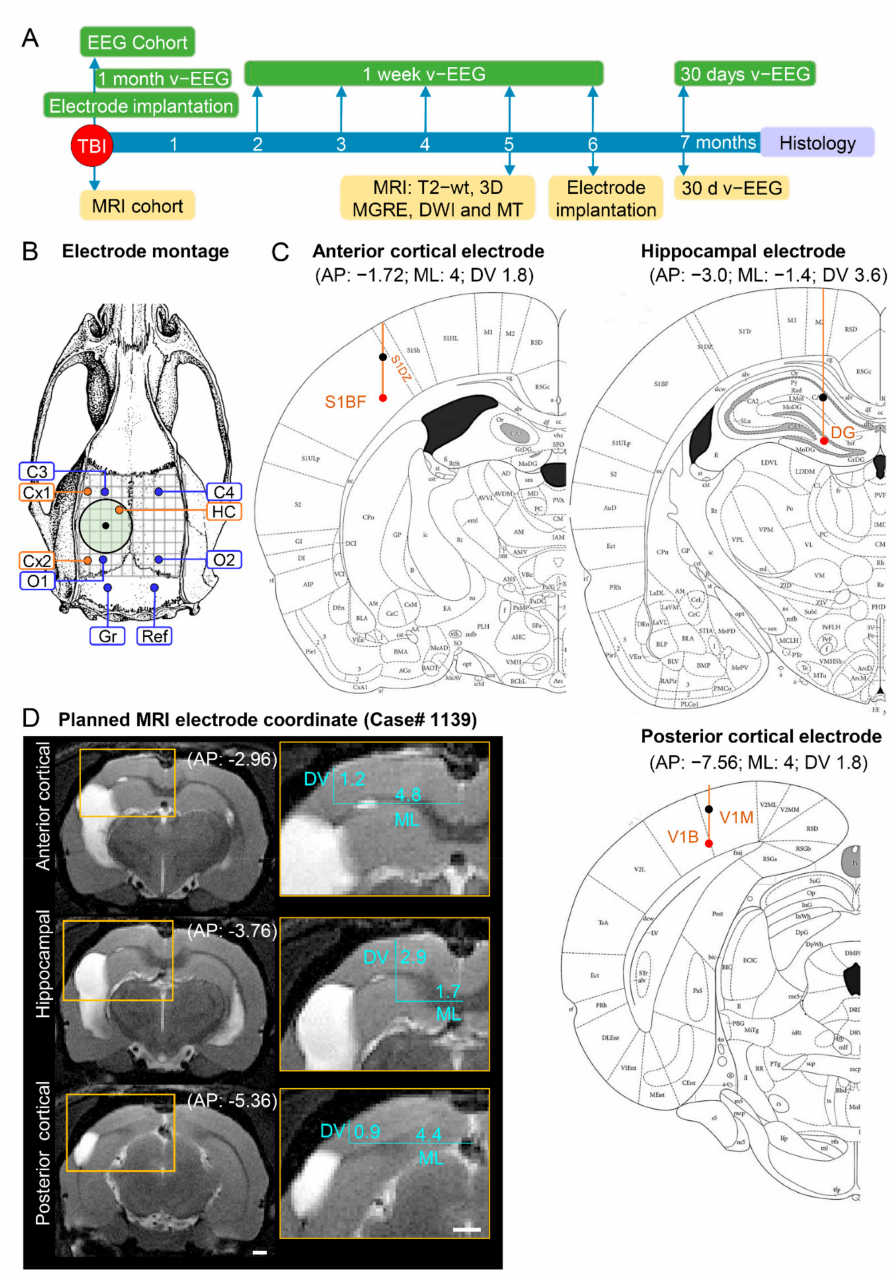
Figure 1. Study design, electrode montage, and atlas or MRI-planned electrode coordinates. ( A ) Study design. Following TBI, rats were divided into either the EEG or MRI cohort. The rats of the EEG cohort were implanted with electrodes after fully righting themselves following induction of TBI. The rats were followed up immediately afterward with 1 month video-EEG and then for 1 week monthly until the 6th post-TBI month. The rats of the MRI cohort were magnetic resonance-imaged at 5 months post-TBI and T2-wt images were used to calculate the coordinates of the intracerebral electrodes implanted at 6 months post-TBI. Both cohorts were continuously monitored with video-EEG for 30 days at 7 months post-TBI to diagnose epilepsy. At the end of the 7-month follow-up period, all rats were euthanized and the brains processed for histological identification of the location of the intracerebral electrodes. ( B ) Electrode montage used in the study. Four epidural screw electrodes (C3, C4, O1 and O2), 3 intracerebral bipolar wire electrodes (anterior cortical Cx1, posterior cortical Cx2, and hippocampal HC), a ground (Gr) and reference (Ref) electrode. ( C ) Atlas plates demonstrating the planned coordinates used in the EEG cohort to implant the anterior cortical, hippocampal,